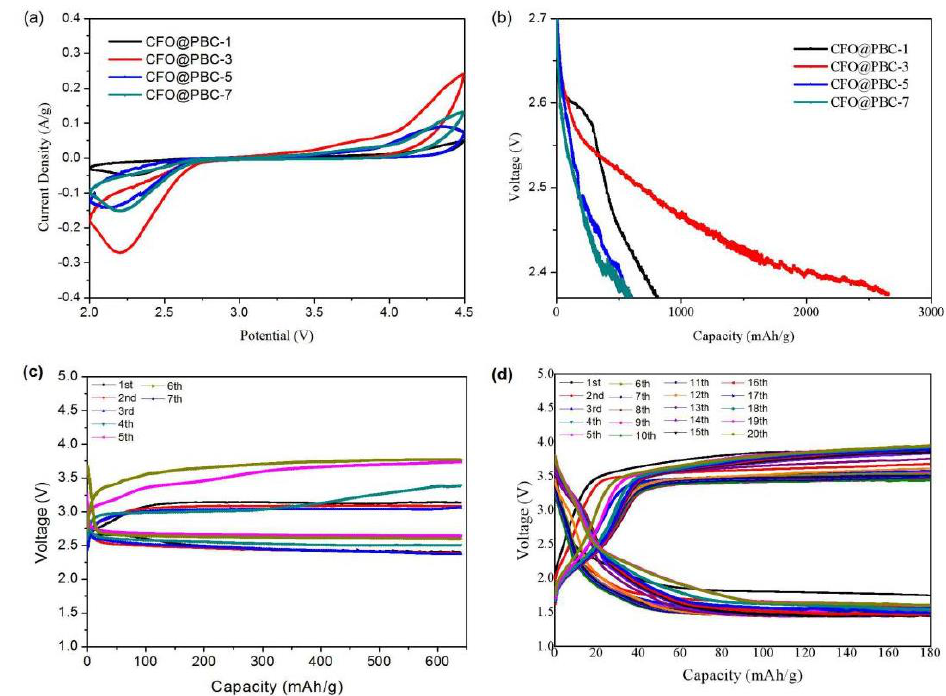
Figure 5. ( a ) CV curves of Li-O 2 cells with different CFO@PBC samples at 0.1 mVs − 1 ; ( b ) initial discharge curves of Li-O 2 cells with different CFO@PBC samples at a current density of 100 mAg − 1 ; ( c ) limited capacitance cycling of Li-O 2 cells with CFO@PBC-3 samples with 640 mAhg − 1 ; ( d ) limited capacitance cycling of Li-O 2 cells with CFO@KB-3 with 180 mAhg − 1 .